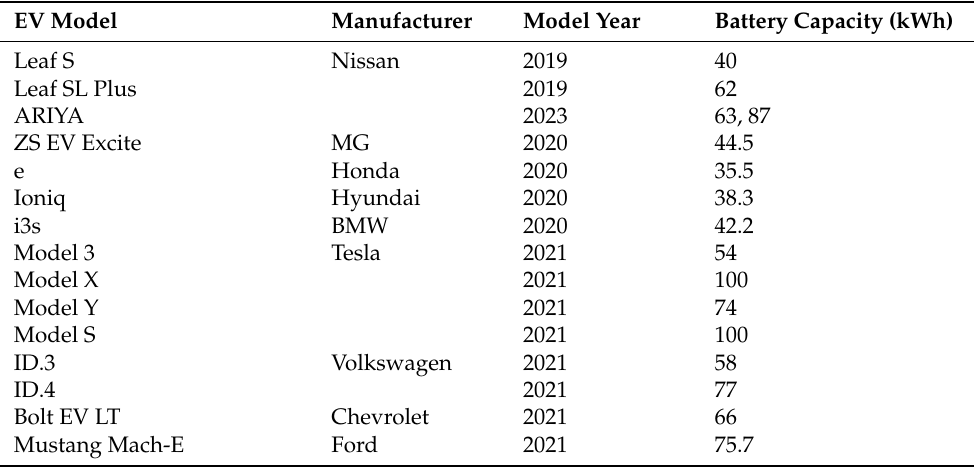
Table 2. Popular commercially available EV battery